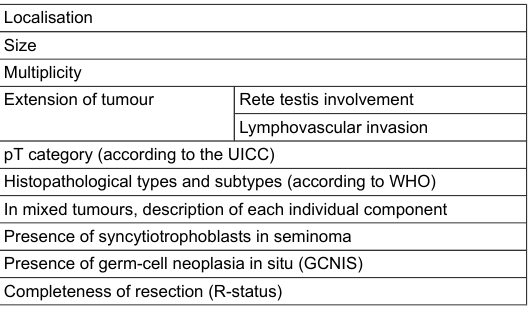
Table 2: Obligatory elements of a histopathological